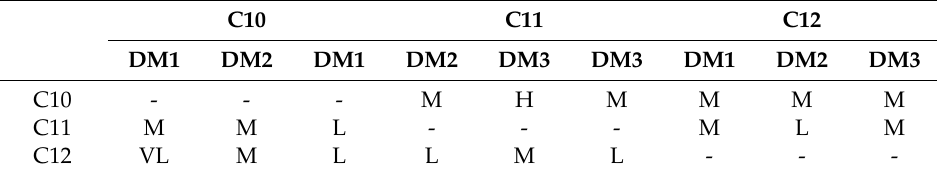
Table A5. Linguistic evaluations of the criteria for dimension 4.